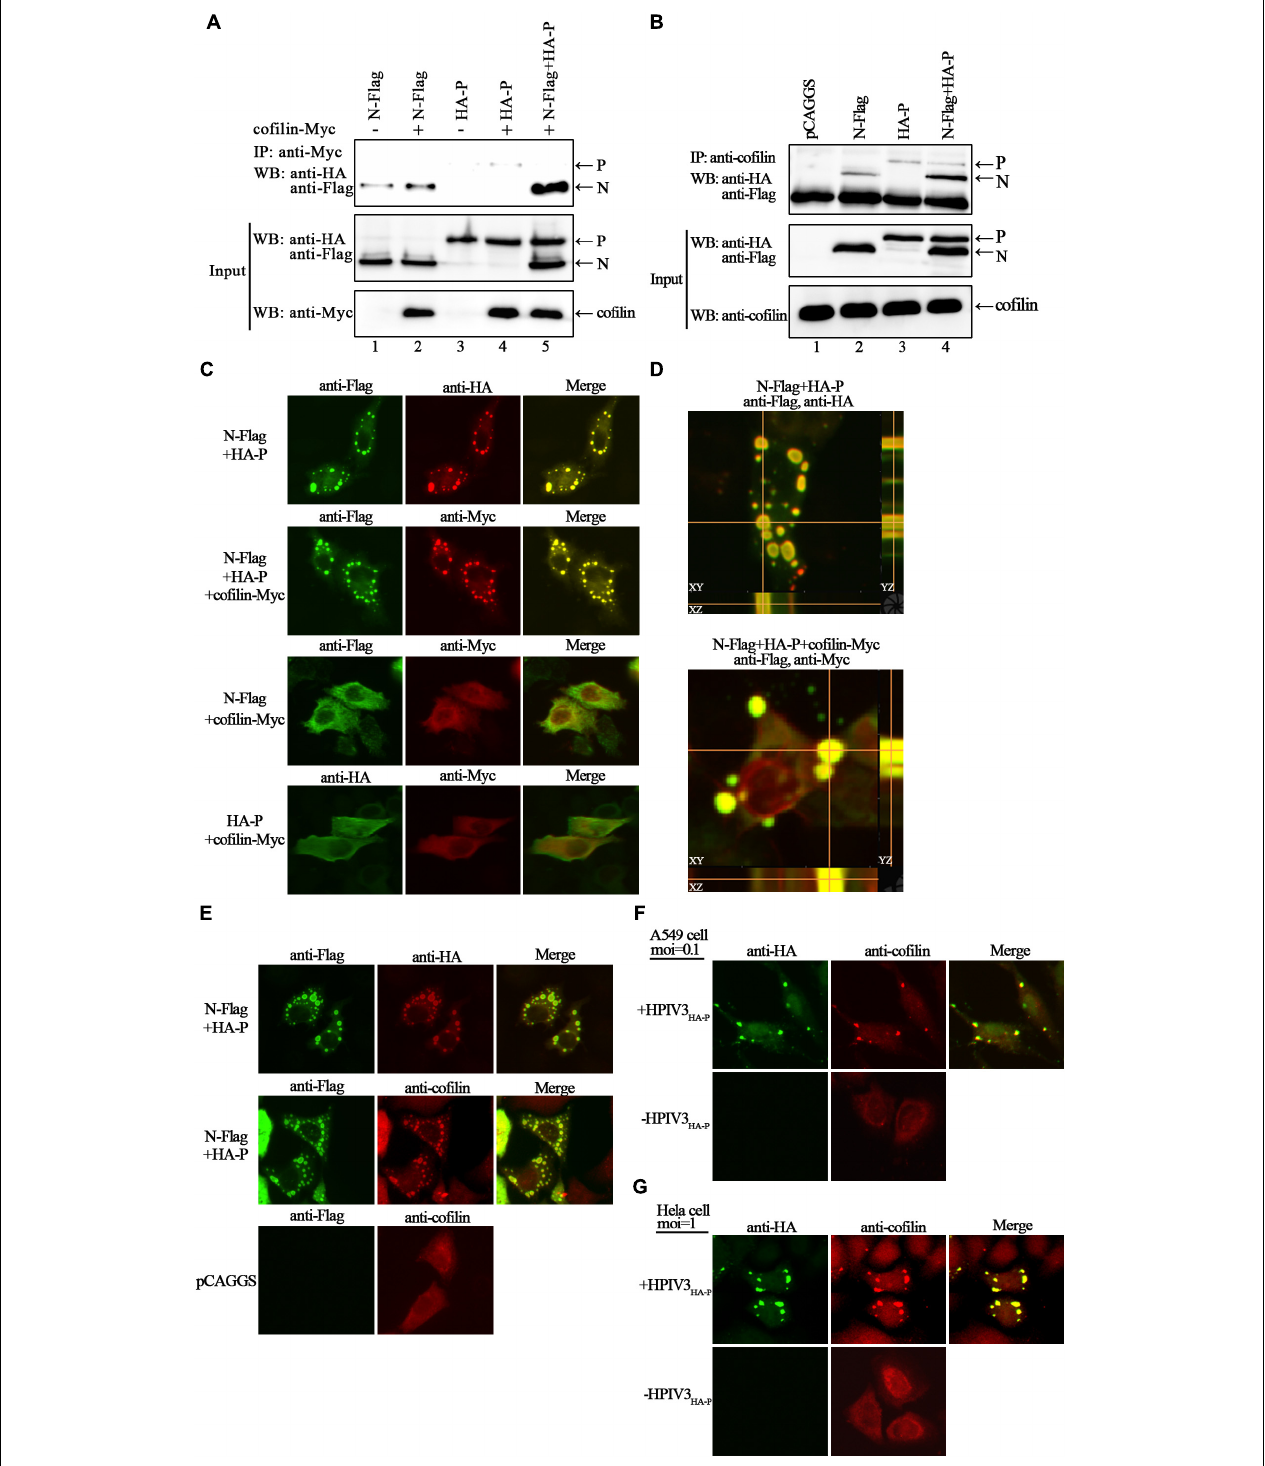
FIGURE 2 | Cofilin interacts with N protein in N–P complex and colocalizes with N–P induced IBs. (A) 293T cells were transfected with plasmids encoding N-Flag, HA-P and cofilin-Myc individually or jointly as indicated. At 48 h posttransfection, the cells were collected and processed to co-IP assays as described in “Materials and Methods” section. Proteins were precipitated with anti-Myc antibody and examined by WB. (B) 293T cells were transfected with the indicated plasmids. At 48 h posttransfection, co-IP assays were performed as described above. Proteins were precipitated with anti-cofilin antibody and examined by WB. (C,D) Hela cells were